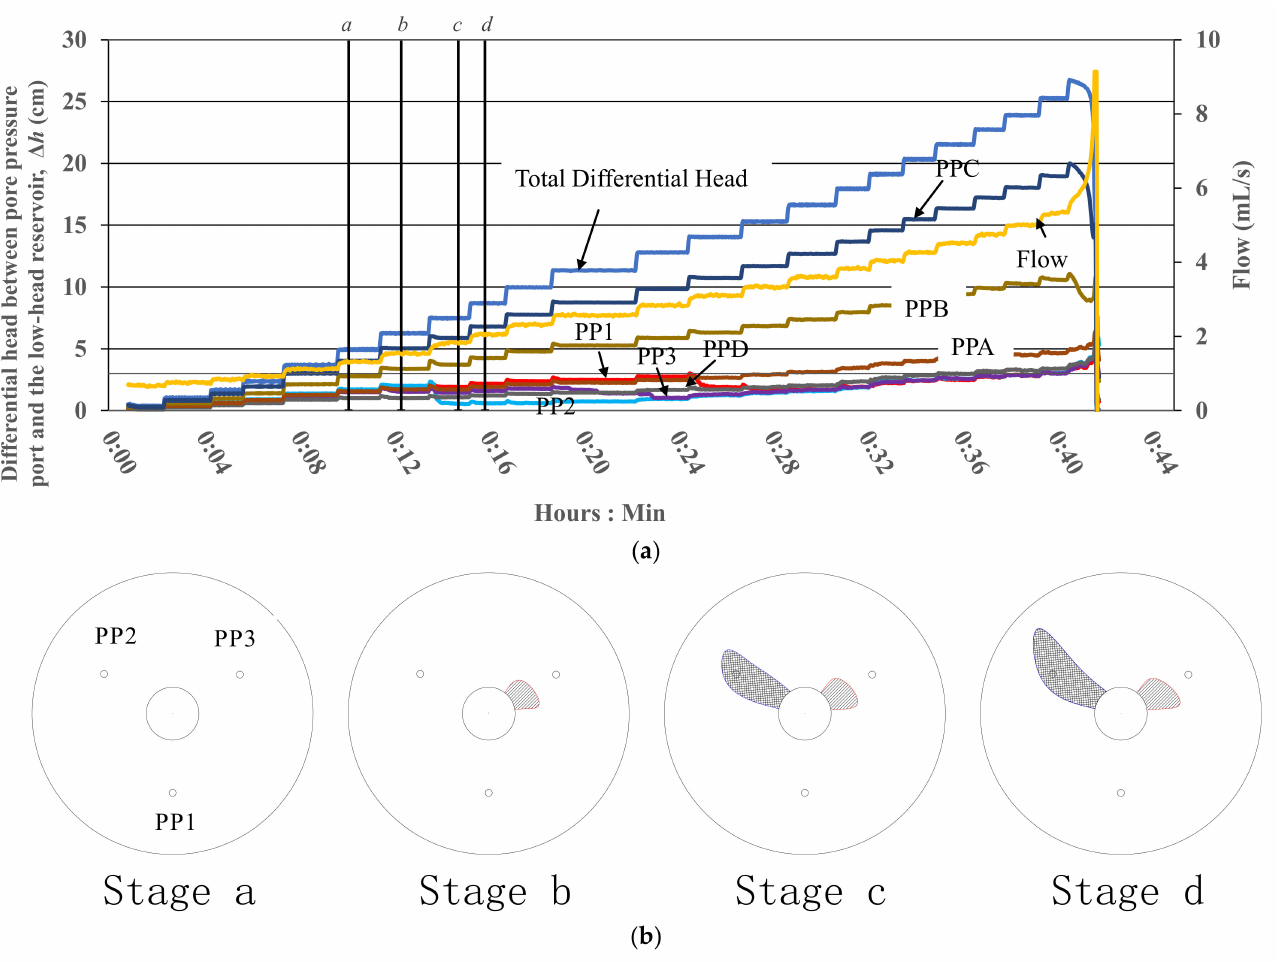
Figure 6. Test data for graded angular sand: ( a ) pore pressure and flow data plotted versus time; ( b ) sketches of BEP development from the video at key